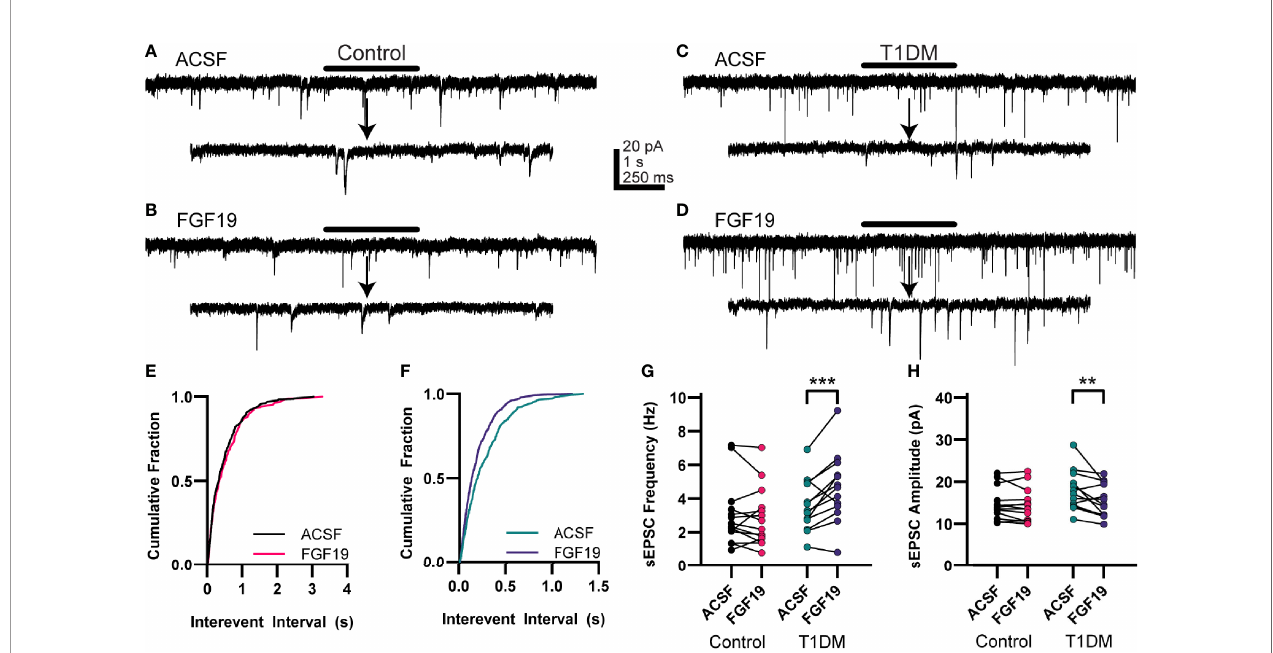
FIGURE 3 | FGF19 increases sEPSC frequency in NTS neurons from hyperglycemic mice. (A, B) representative voltage clamp recordings of sEPSCs in NTS neurons from control mice. (C, D) Representative voltage clamp recordings of sEPSCs in NTS neurons from T1DM mice. (E) Cumulative fraction plot for the traces from (A, B) . (F) Cumulative fraction plot for the traces from (C, D) . (G) FGF19 does not alter sEPSC frequency in control mice (n = 14; p > 0.05) but signi fi cantly increases sEPSC frequency in T1DM mice (n = 13; ***p < 0.001). (H) FGF19 does not alter sEPSC amplitude in control mice (n= 14; p > 0.05) and slightly decreases sEPSC ampltide in T1DM mice (n = 13; **p < 0.01). Arrow indicates 2 s expanded portions indicated by the black bar above the trace. All cells recorded at -85 mV. Repeated measures generalized linear mixed model analysis used for all analyses. No pharmacological blockers were applied for these